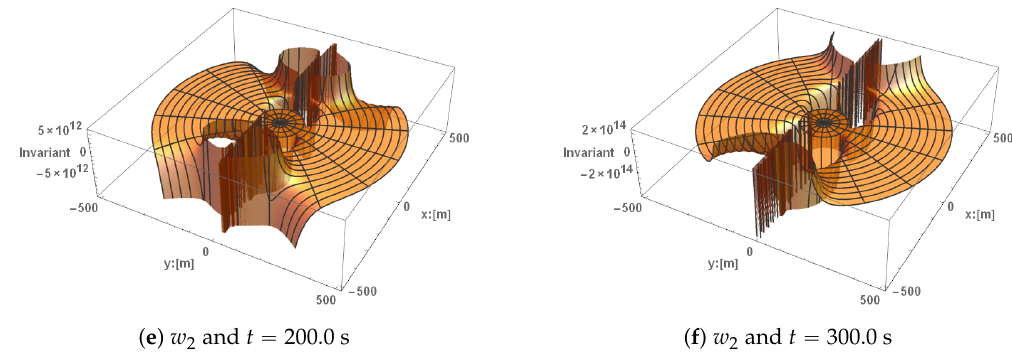
Figure A3. The time, t , of the invariant w 2 is plotted in the figures above. The other parameters were set to be σ “ 50,000 m ´ 1 , ρ “ 100 m, and a “ 1.0 m s ´ 2 . The plots were rendered using Mathematica’s ® RevolutionPlot3D. It plots a function by rotating the function around the z-axis. The amount that the space diverges from being flat is represented by the invariant function’s magnitude, and its amount is labeled on the vertical axis. The x and y-axis are displayed on the plots, and they display the distance from a spaceship in the flat portion at the center of each figure. Each radial line in the plot corresponds to a distance of approximately 33 m. The constant portion to the right of the harbor is to the front of the warp bubble, and the constant portion to the left of the harbor is the back of the warp bubble.